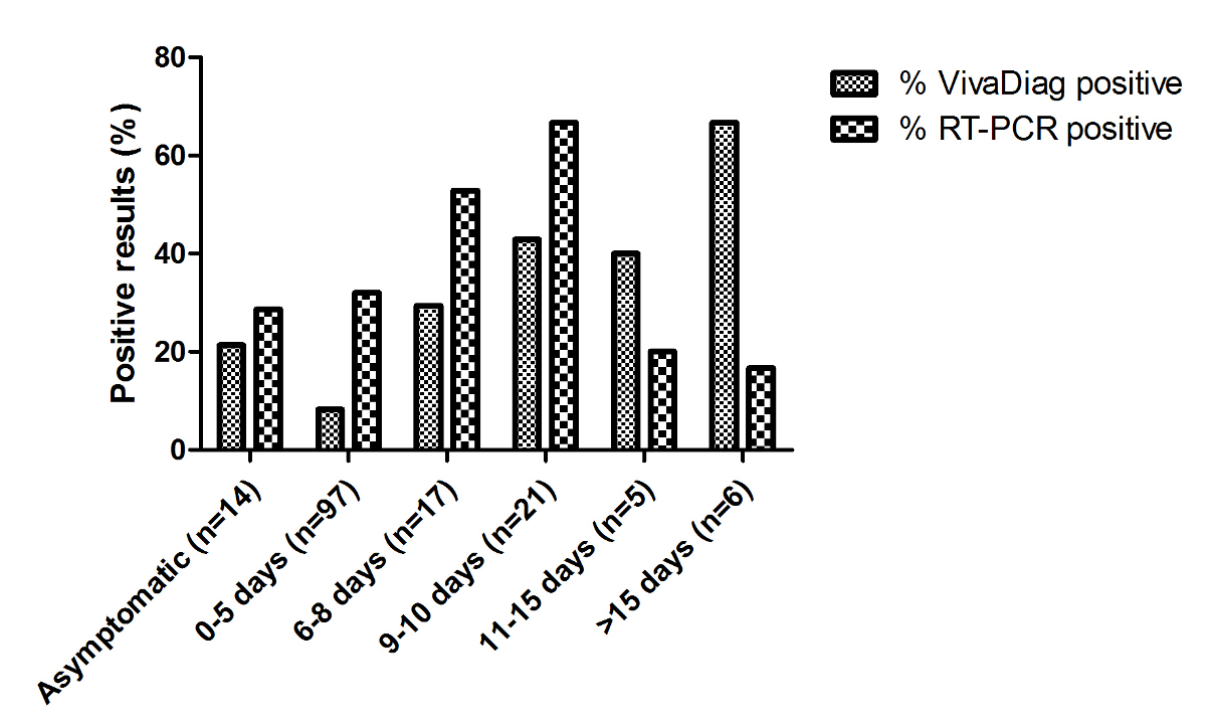
Figure 2. Bar plot depicting the distribution of the proportion of positive results from the VivaDiag serological test and those from RT-PCR testing for SARS-CoV-2 detection on oropharyngeal swab specimens according to time after symptom onset to test performance. RT-PCR: real-time polymerase chain